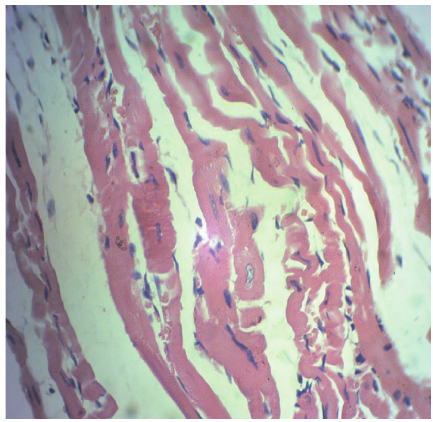
Figure 4: A cross-sectional representative of a DOX-intoxicated rat heart treated with 200mg/kg/day CVE showing mildly congested myocytes with occasional meganuclei suggestive recovery from doxorubicin toxicity ( × 400 magnification, hematoxylin-eosin stain).